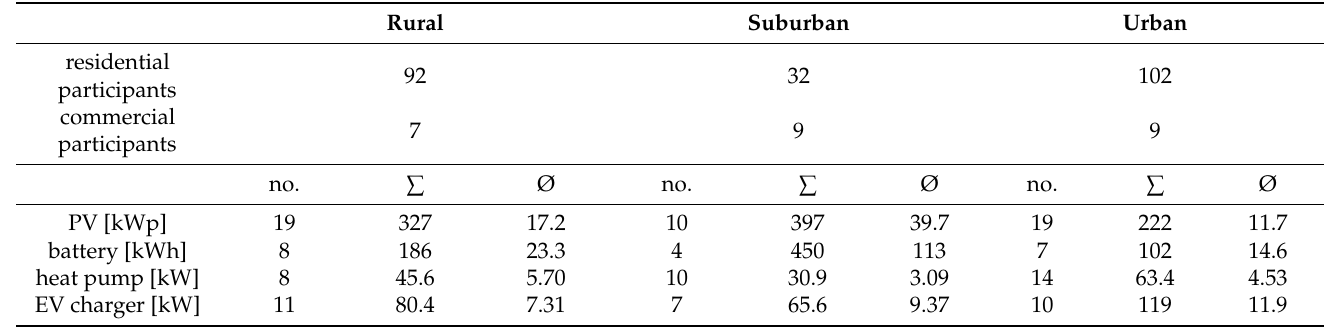
Table 2. Scenario definition based on grid topology, number of residential and commercial partici- pants, and number, installed capacity, and mean installed capacity of flexible assets [29]. Rural Suburban Urban 92 32 102